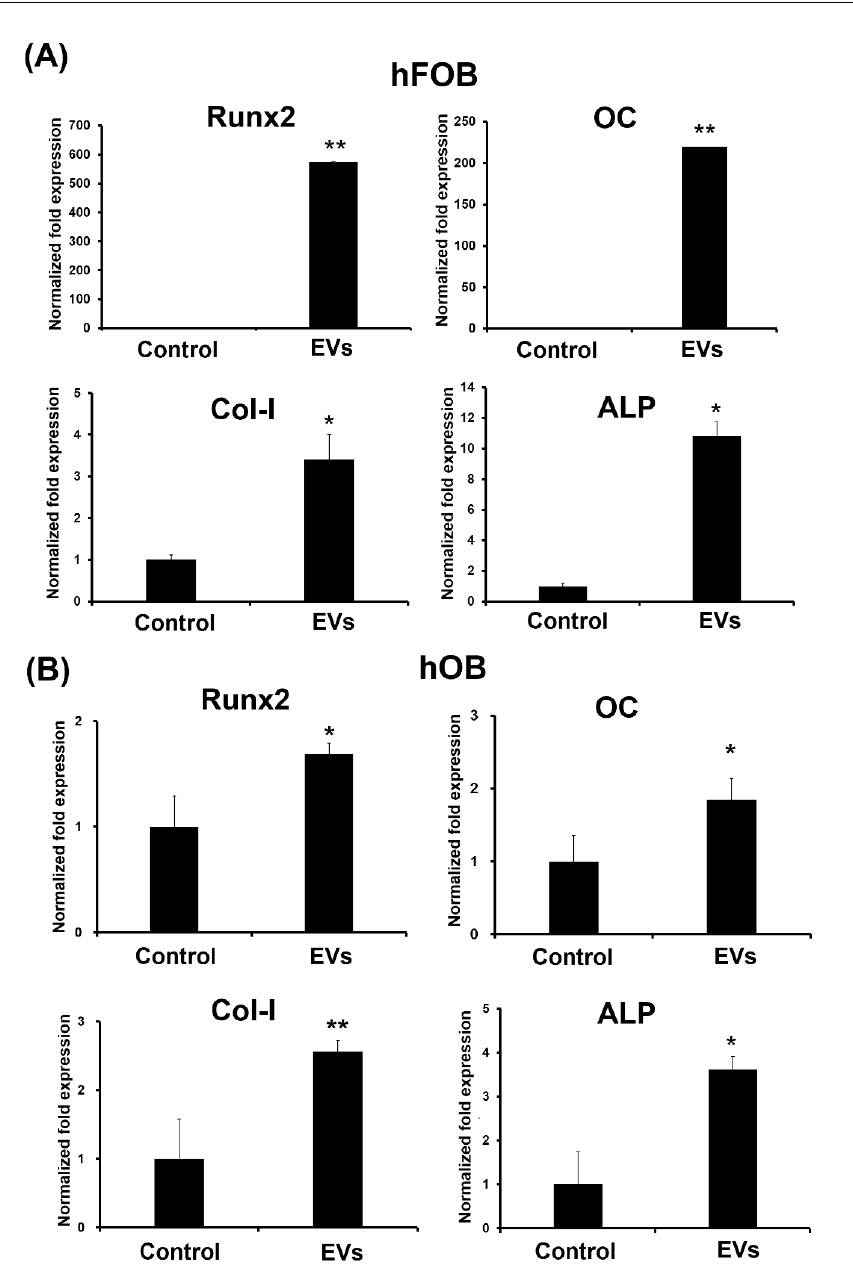
Figure 5. ADSC-EVs promoted osteogenic marker gene expression in osteoblasts. The hFOBs ( A ) and hOBs ( B ) were treated with ADSC-EVs at concentrations of 0 (Control: control group) or 10 9 particles/mL (EVs: EV group) for 5 days. The mRNA expression levels of the osteogenic marker genes (runt-related transcription factor 2 ( Runx2 ), osteocalcin ( OC ), collagen type I ( Col-I ), and alkaline phosphatase ( ALP )) of hFOBs and hOBs were measured. Gene expression levels are expressed relative to the control group, which is defined as 1. Data are presented as the mean ± SD ( n = 3). * p < 0.05 and ** p < 0.01 for comparisons with the control group.